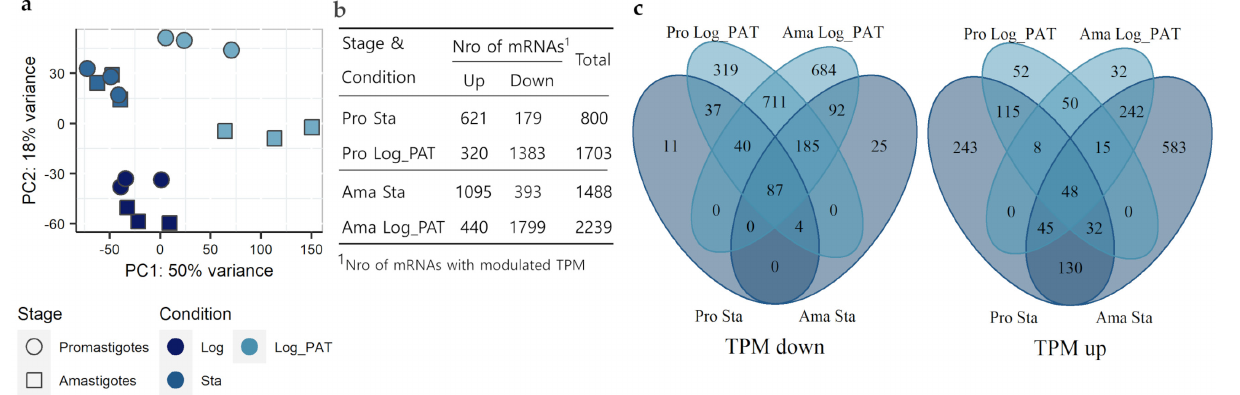
Figure 3. Transcriptome composition and its modulations during quiescence. ( a ), Principal component analysis shows quiescent cells induced by stationary phase and PAT pressure differ in their transcriptome composition compared to proliferating cells in both promastigotes and amastigotes. ( b ), Summary of mRNAs modulated in each Leishmania stage and condition. ( c ), Venn Diagrams showing the number of mRNAs with modulated TPMs in the conditions Sta and Log_PAT compared to Log in each Leishmania stage. Pro, promastigotes; Ama, Amastigotes.